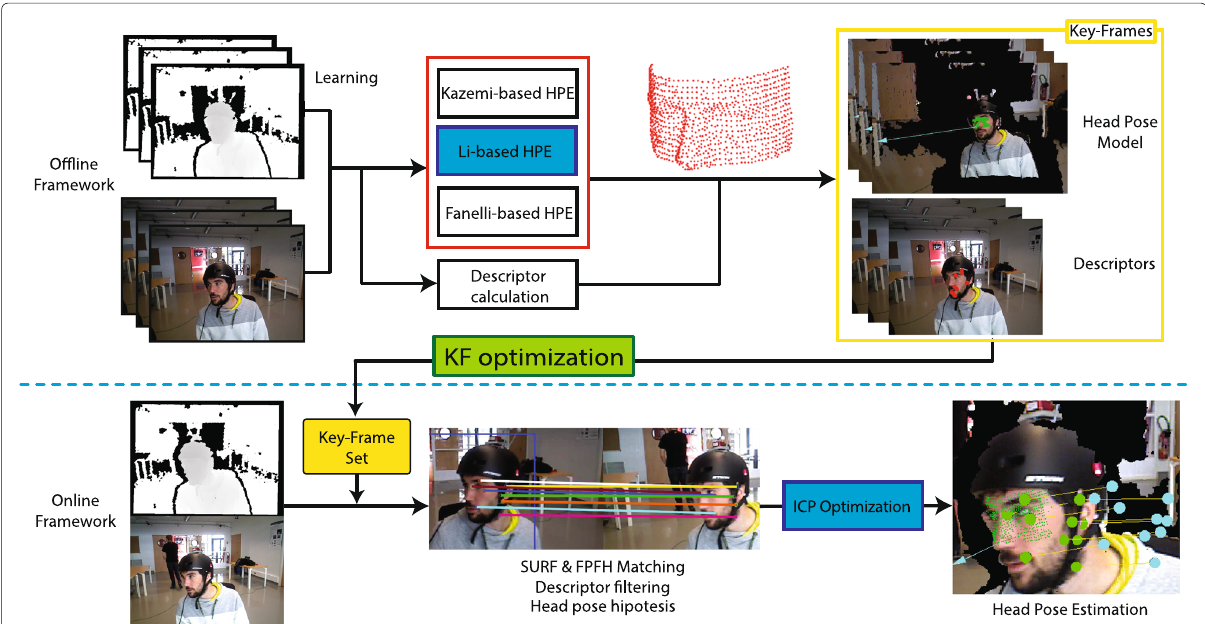
Fig. 1 Pipeline of the proposed head pose estimation method. Top: offline framework. The input is a RGB-D stream of the person to track. Rough pose estimation is done (red block), and most relevant frames are selected (yellow block). Then, an optimization process improves the pose accuracy (green block). Bottom: online pose estimation process. The current image is shown at left. The key frame with the best matching score is selected and depicted at right. Finally, ICP refines the estimation (right